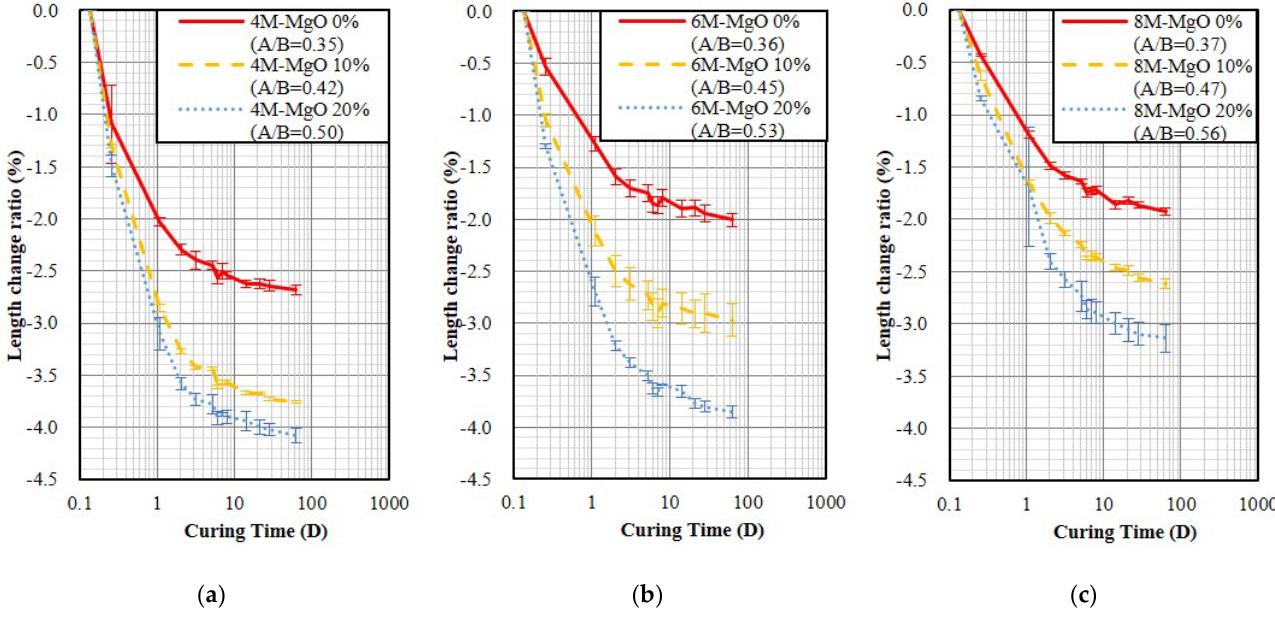
Figure 4. The length change ratios of the GP specimens (fixed A/B). ( a ) 3 h unmolding and A/B is 0.50 (room-temperature); ( b ) 24 h unmolding and A/B is 0.53 (air-dry).